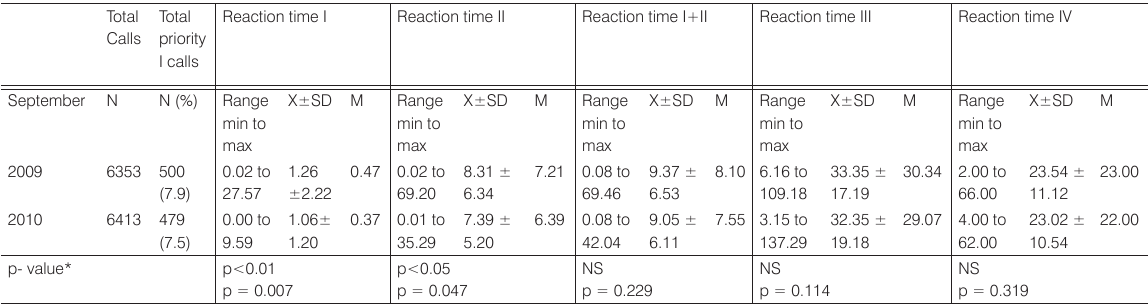
Table 1. Comparative analysis of total number of physician calls, total number of priority I emergency calls and response time I to IV in September 2009 vs September